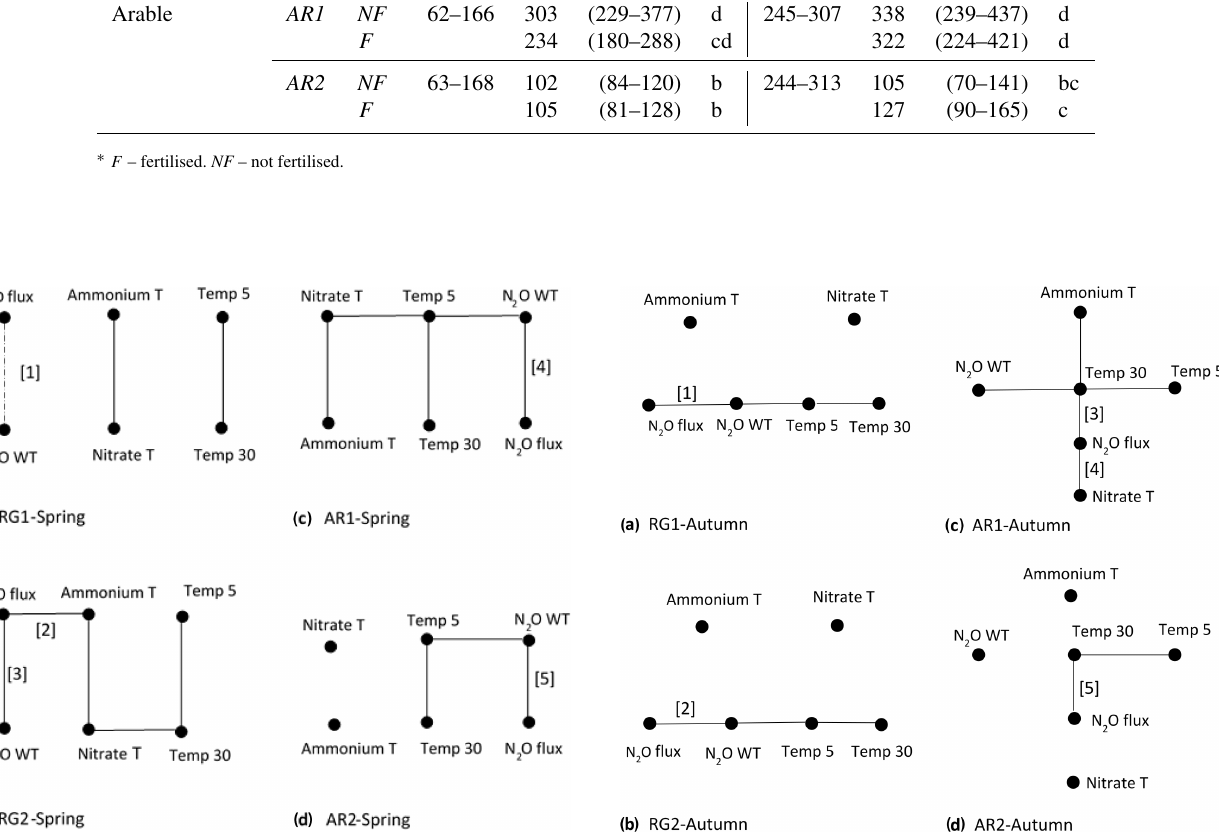
Figure 7. Results of a graphical model for each site–crop combi- nation in spring: (a) RG1-Spring, (b) RG2-Spring, (c) AR1-Spring, and (d) AR2-Spring. The edges (lines) connecting vertices (points) indicate significant conditional correlation between the variables given the other variables. The statistical results for direct effects on